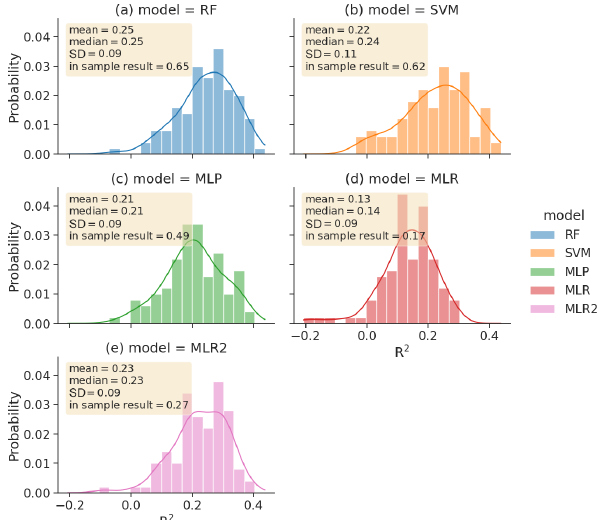
Figure 5. Out-of-sample model performance and distribution of R 2 scores of deseasonalized and standardized water vapor at 82hPa, averaged between 15 ◦ S and 15 ◦ N. The various models are RF (blue), SVM (orange), MLP (green), MLR (red) and MLR2 (pink). The MLR2 model is the same as the MLR model but with ENSO 2 and ENSO × QBO predictors. The mean, median and standard de- viation (SD) are noted for each distribution in a yellow text box, along with the in-sample R 2